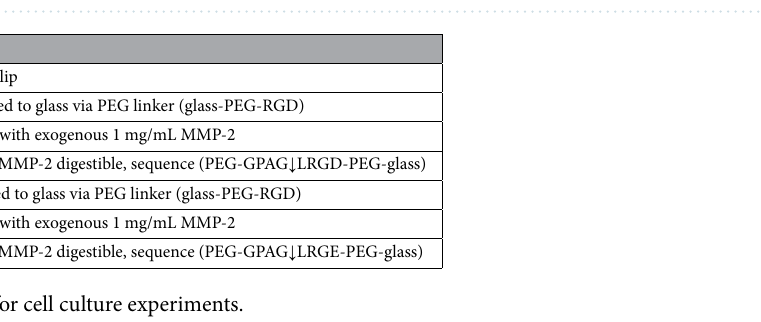
Figure 3. MMPs can cleave PEG from the peptide and reveal RGD. ( a,b ) Tof–SIMS data showing removal of the PEG group with the addition of MMPs-2 and 9 in more detail. ( c ) Treatment of the DIGE-D surface with SSC supernatant containing 10 ng/mL of MMP-2 (active) and 0.4 ng/mL of MMP-9 (latent) resulted in some cleavage of PEG.